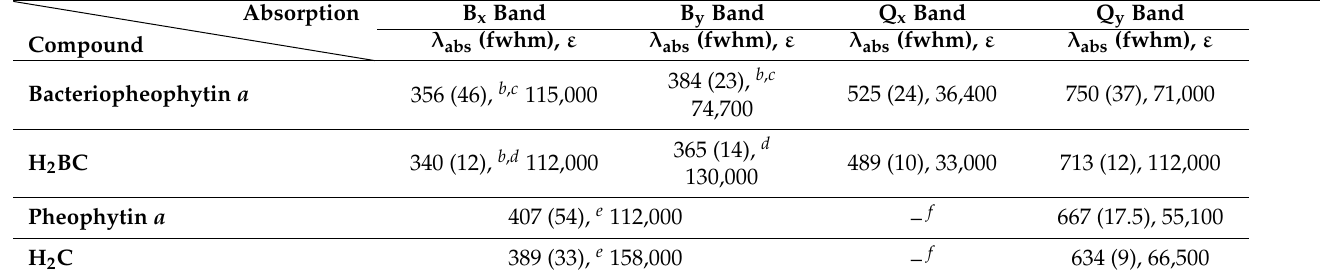
Table 1. Spectral parameters of native versus naked macrocycles a .